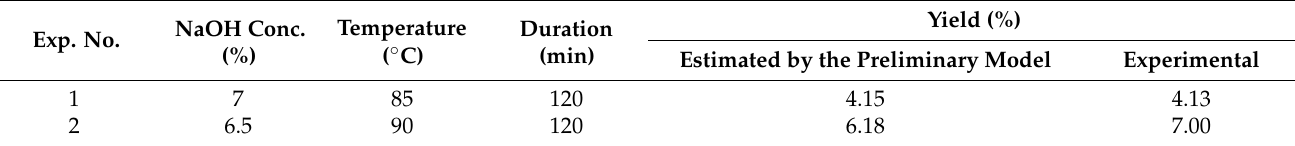
Table 3. New experimental points, and the yield values.